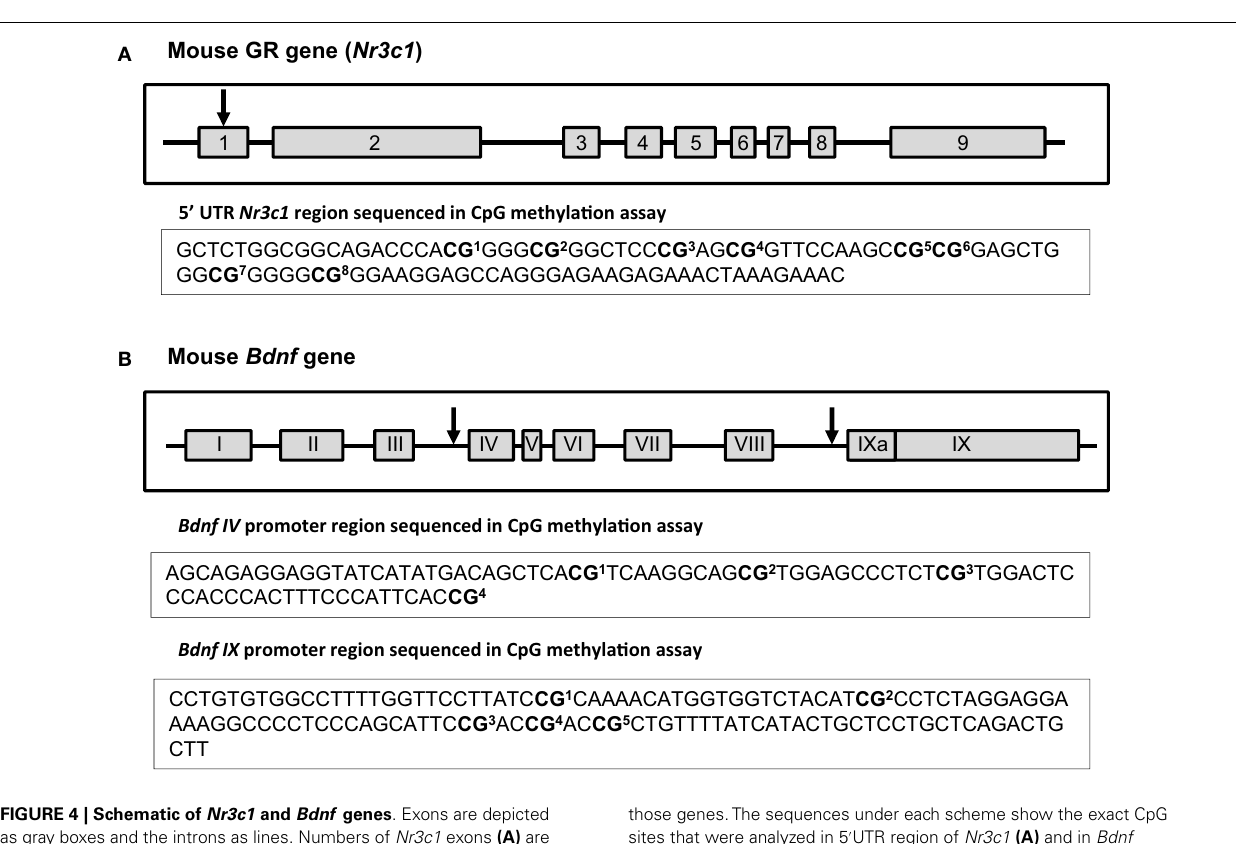
FIGURE 4 | Schematic of Nr3c1 and Bdnf genes . Exons are depicted as gray boxes and the introns as lines. Numbers of Nr3c1 exons (A) are indicated in Arabic numerals while numbers of Bdnf exons (B) are indicated in Roman numerals to conform to standard nomenclature. The arrows show the approximate location of the examined sites within